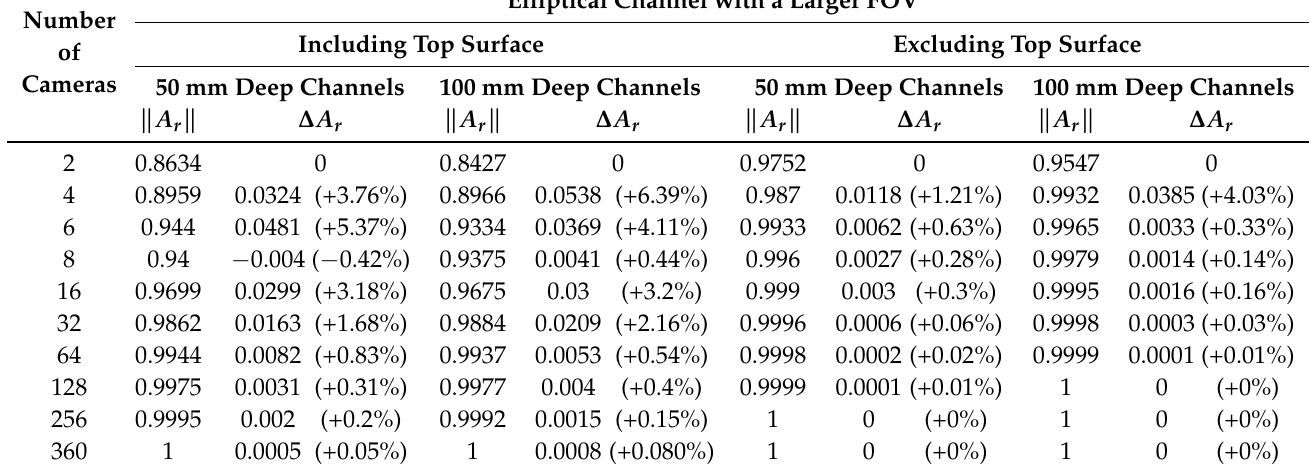
Table 6. Reconstructable areas ( A r ) of the “elliptical channel” models for different numbers of cameras using an larger FOV (60mm 60mm). The area values for each mesh are normalized to the area of the respective mesh which is reconstructable × with 360 cameras. ∆ A r denotes the increase in reconstructable area from the next smaller number of